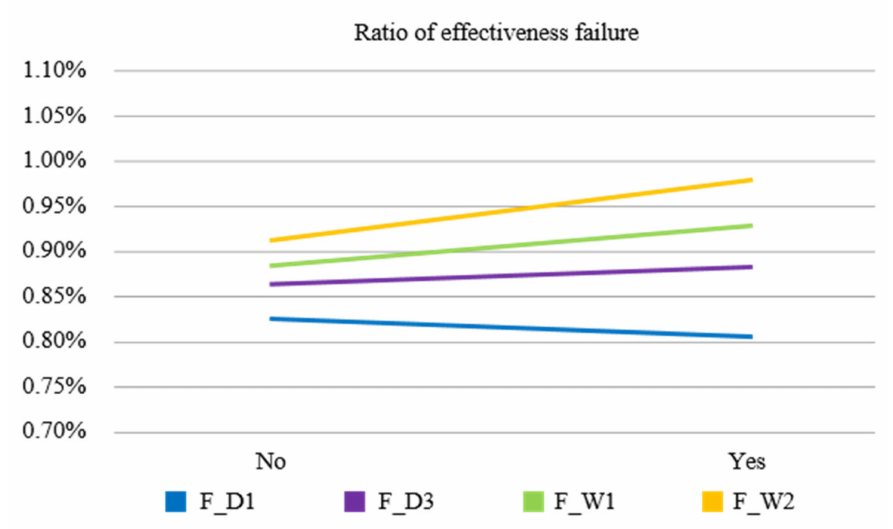
Figure 9. Ratio of effectiveness failure.